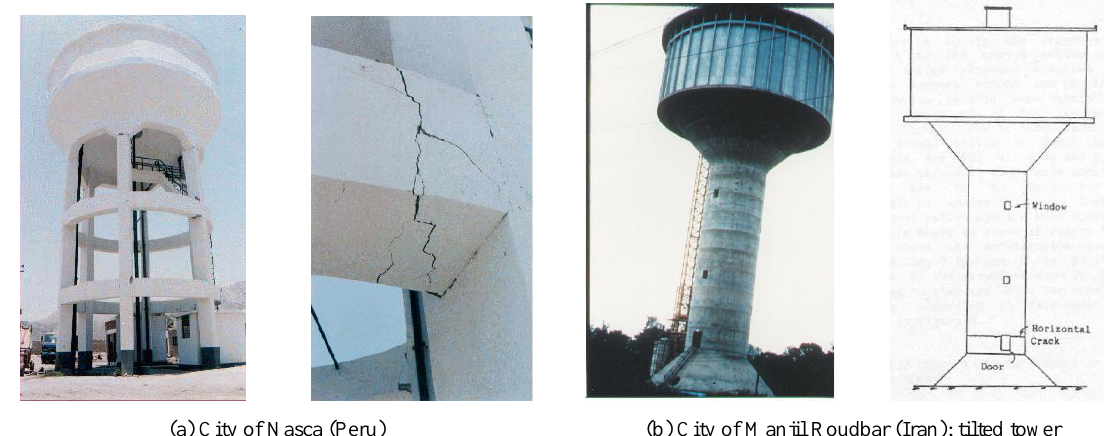
Fig. 2. Damage inflicted to: (a) Hintze-type elevated water tanks, (b) cylindrical